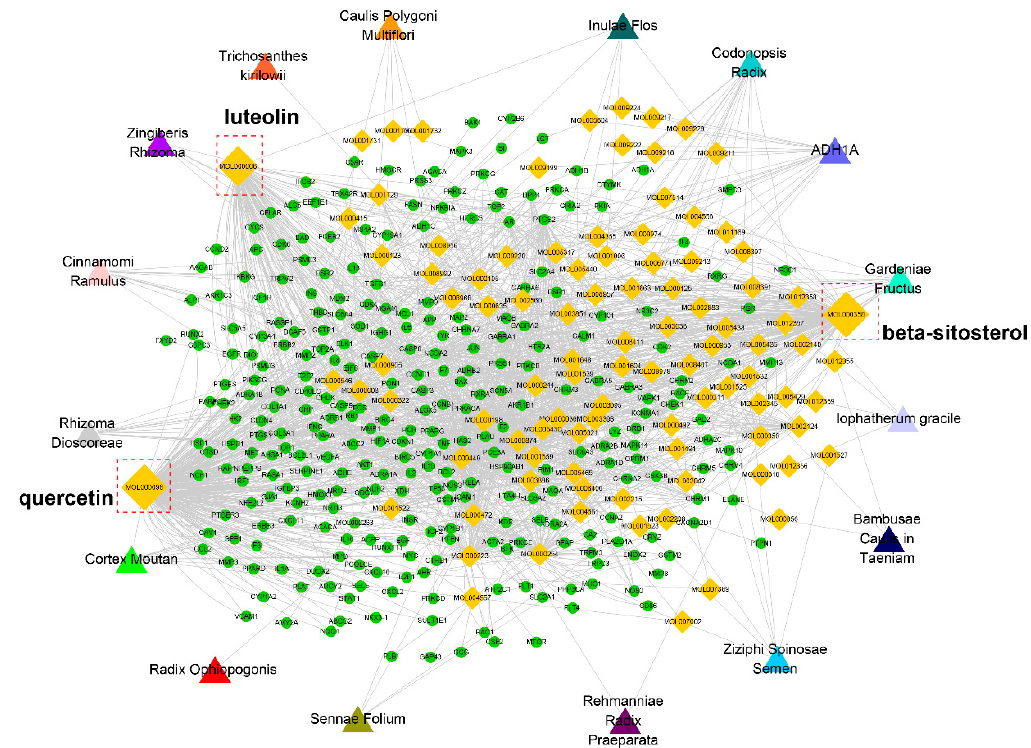
Figure 4. Compound-target network. The network was constructed by linking active compounds (marked by compound ID) from different herbs and their predicted targets.